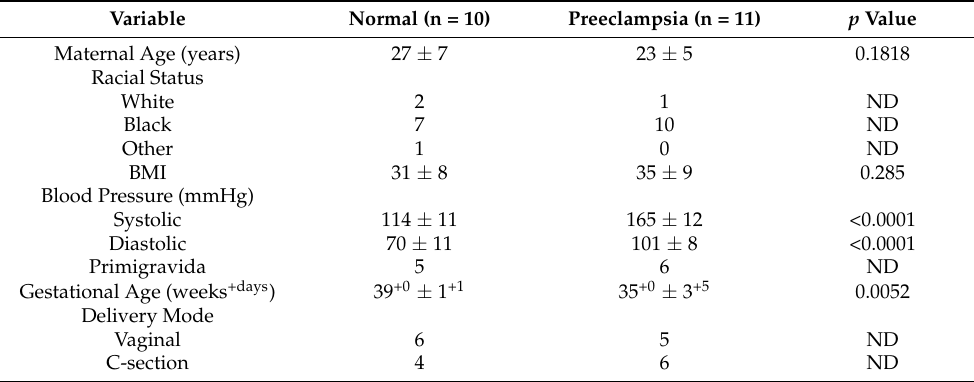
Table 2. Demographic data for placentas and umbilical cords used in this